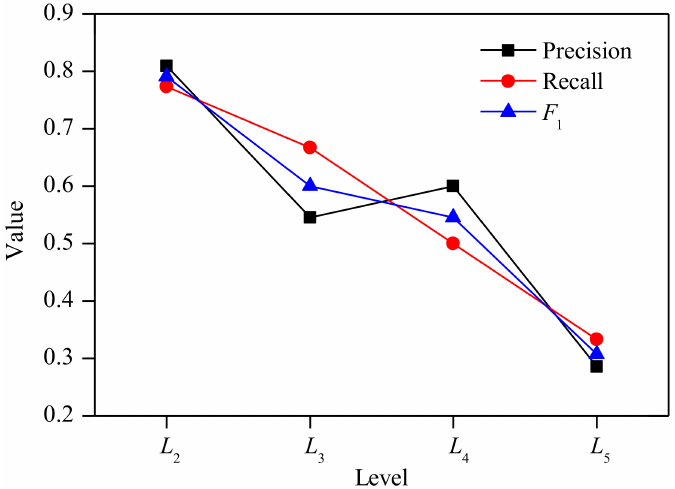
Figure 7. Average accuracy of five-fold cross validation under different number of